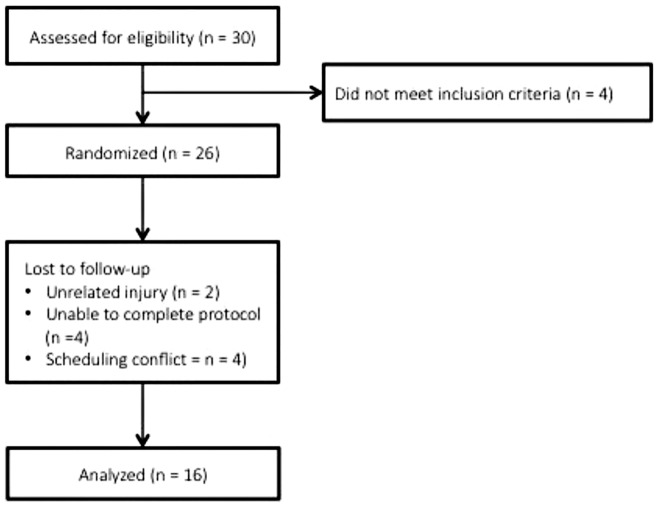
Consort diagram.